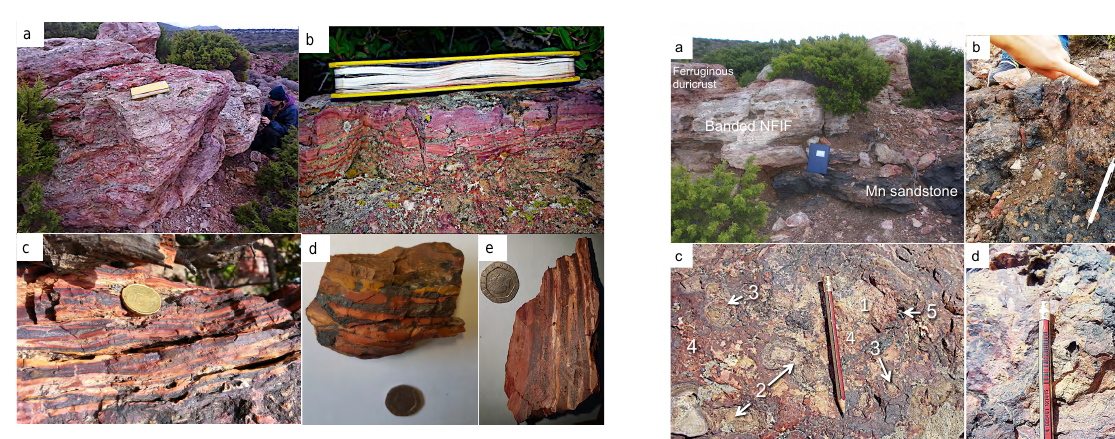
Figure 7. Examples of the NFIF banded iron rocks. (a–c) Field pho- tographs. (d) Handheld banded Fe sample. (e) Sawn NFIF sample with laminated Fe-rich bands alternating with Si-rich bands.